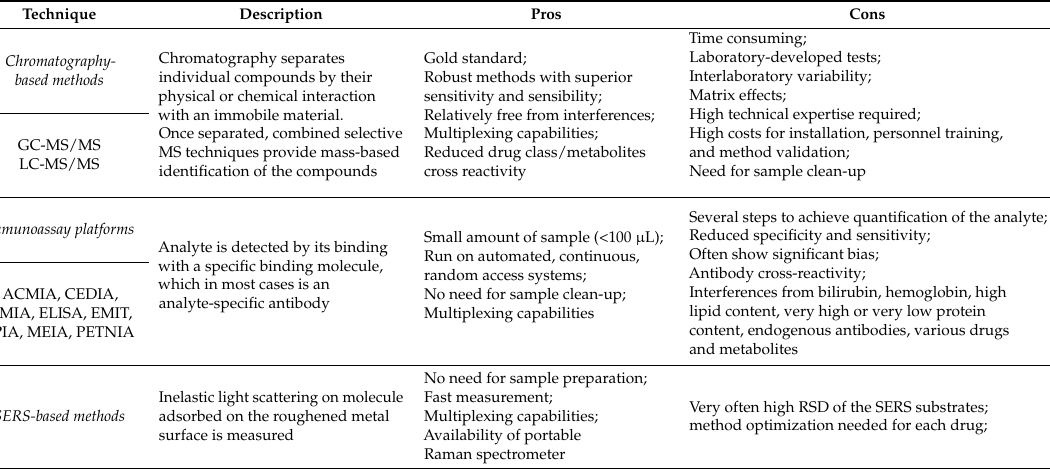
Table 1. Pros and cons of analytical techniques currently used in TDM, compared with SERS.